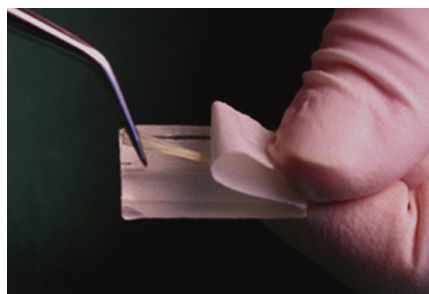
Figure 3: Resin impregnated fiber material is taken out from the package, which can be used as mold for adapting the fibers on tooth